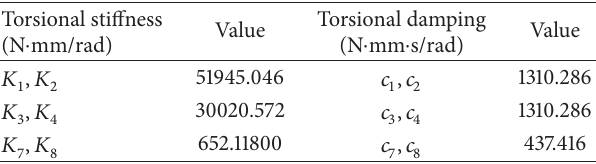
Table 3: Values of the torsional stiffness and damping. Torsional stiffness